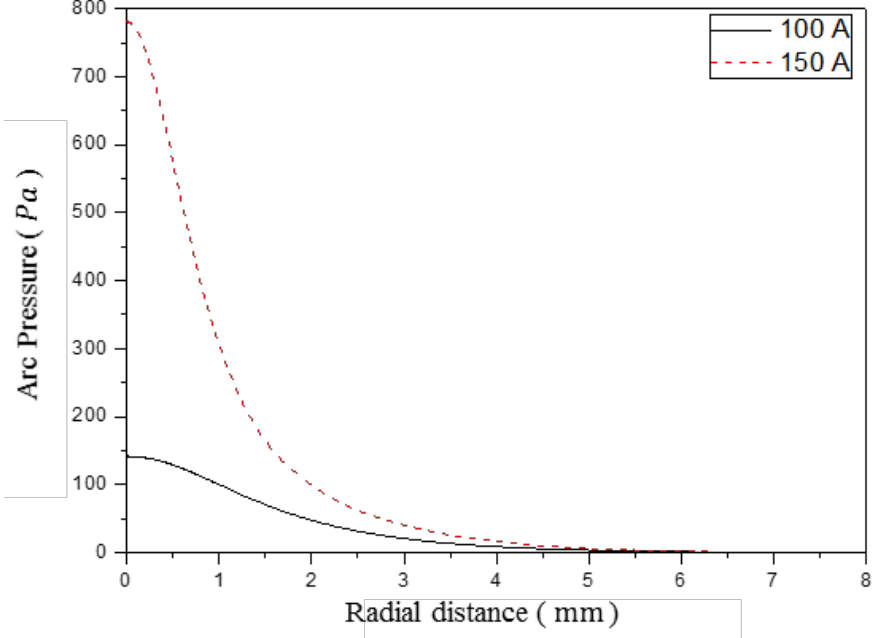
Figure 7. Arc pressure change on the anode surface with the different input current.